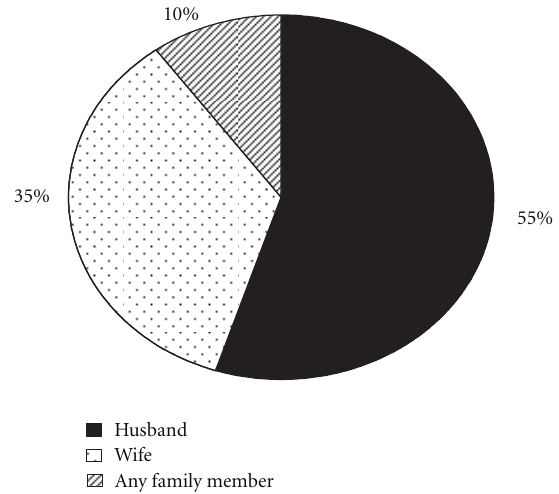
Table 5: Cross-tabulation of gender, family size, and size of the land owned against respondents’ willingness to manage shea trees ( N = 80).